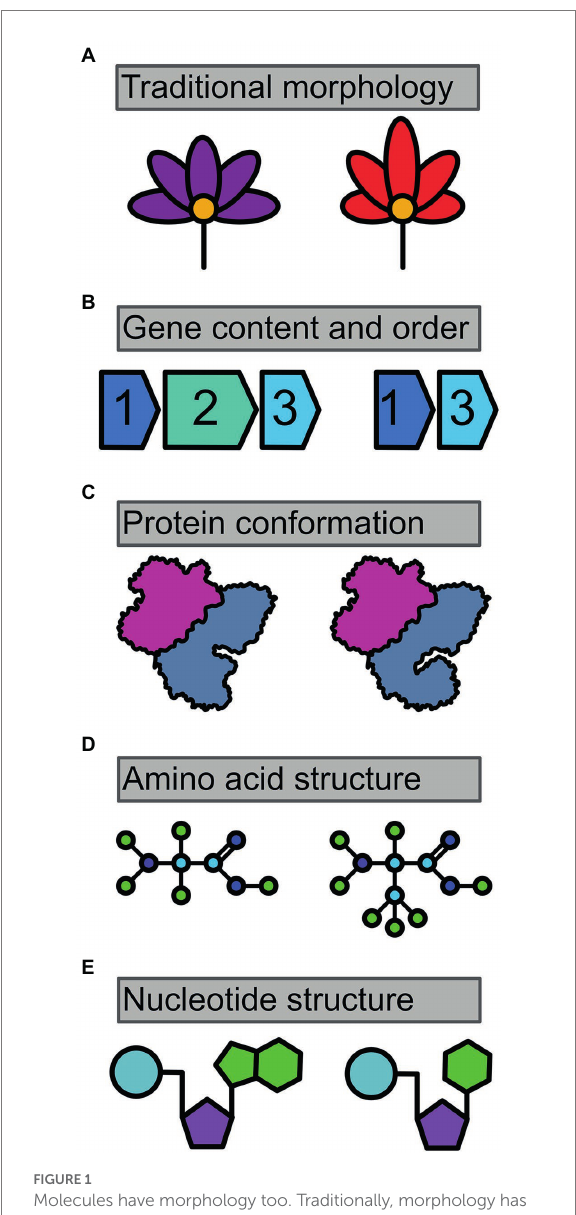
FIGURE 1 Molecules have morphology too. Traditionally, morphology has been limited to structures that are easily visualizable by eye or microscopy, such as the differences in (A) flower color and petal dimensions. However, morphology can be found at a number of levels when examining molecular data. (B) Gene content, gene order, and synteny are strong characters, as are karyotypes. (C) Protein conformation is three-dimensional, and easily modeled for comparisons. Lastly, even (D) amino acids and (E) nucleotides have clear differences in physical structure, much like traditional